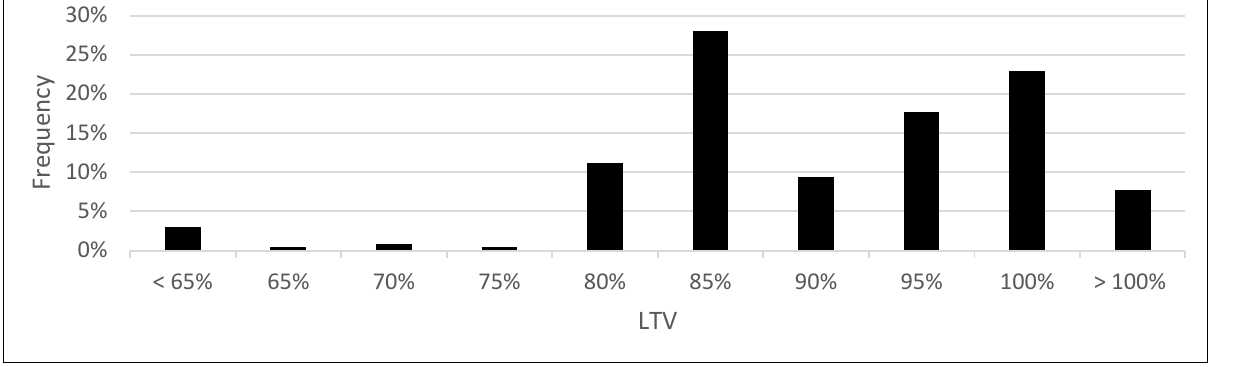
Figure 3: Loan-to-value (LTV) offered for home loans